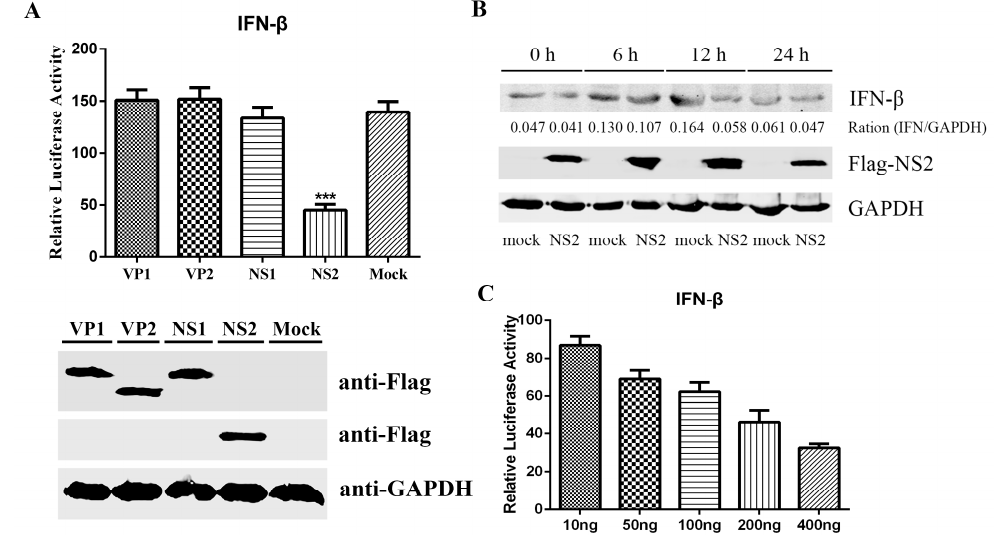
Figure 2. FPV NS2 as a negative regulator impedes SeV-mediated IFN- β induction. ( A ) Effects of protein-coding genes of FPV on the SeV-induced IFN- β promoter activation in F81 cells. The cells in this experiment were co-transfected with IFN- β -Luc, the Renilla luciferase construct pRL-TK and one of the recombinant plasmids pFlag-vp1, pFlag-vp2, pFlag-ns1, or pFlag-ns2. Twenty-four hours later, the cells were stimulated with SeV. The luciferase activity was measured at 12 h after simulation. The values were normalized to the Renilla activity. The data represent the mean values of three independent experiments. The error bars represent standard deviations, and “*” indicates significant differences ( p < 0.05) between groups. The expression of VP1, VP2, NS1, or NS2 was monitored by immunoblotting using a mouse anti-Flag antibody; GAPDH was used as a loading control. ( B ) The SeV-mediated IFN- β expression is disrupted by NS2. F81 cells were transfected with p3 × Flag-NS2. At 12 h post transfection, the cells were inoculated with SeV. The cell lysates at 0, 6, 12 and 24 h after SeV infection were analyzed by immunoblotting (IB) using anti-Flag and anti-IFN- β antibodies. ( C ). NS2 inhibits IFN promoter activity in a dose-dependent manner. F81 cells were co-transfected with IFN- β -Luc, pRL-TK and different amounts of p3 × Flag-NS2 (10, 50, 100, 200 or 400 ng). At 12 h post transfection, the cells were inoculated with SeV. Twelve hours after infection, the cells were harvested, and the luciferase activities were measured. The values were normalized to the Renilla activity. The data represent the mean values of three independent experiments. The error bars represent standard deviations, and the asterisks indicate significant differences (*: p < 0.05; **: p < 0.01; ***: p < 0.001) between